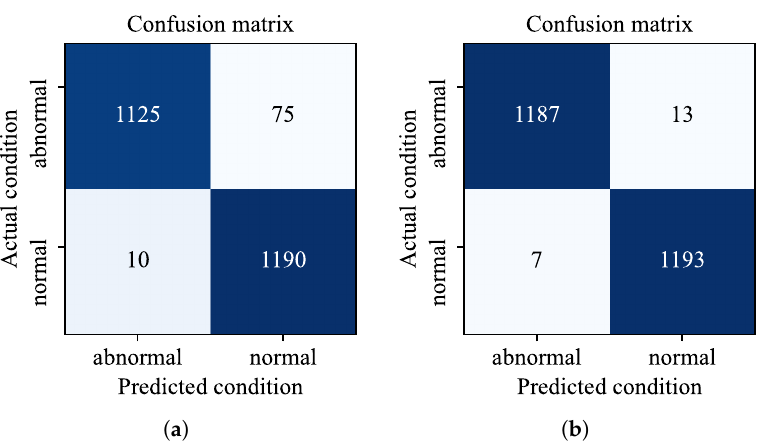
Figure 9. Confusion matrix: ( a ) Confusion matrix of CRNN, ( b ) Confusion matrix of MS-CTCN.